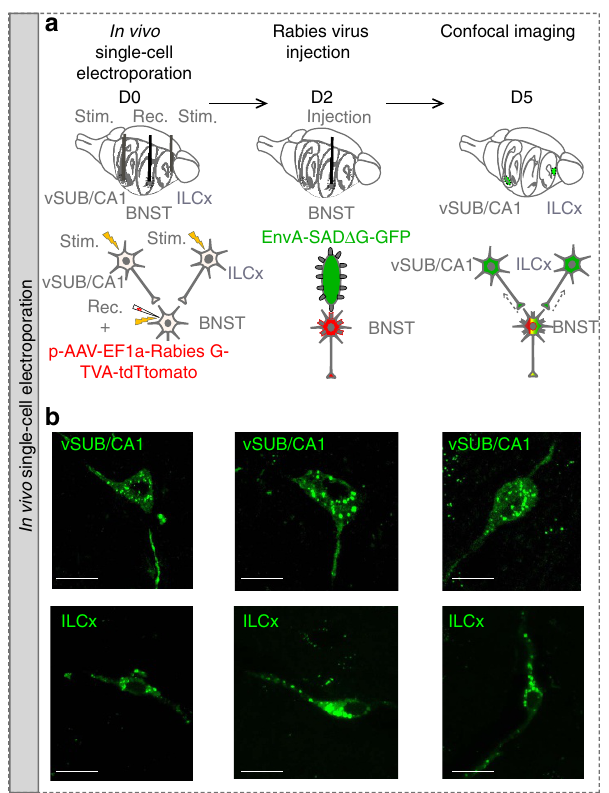
Figure 2 | Trans-synaptic tracing from single-electroporated amBNST neurons. ( a ) Experimental protocol of in vivo single-cell electroporation of amBNST neuron coupled with a recombinant monosynaptic retrograde- pseudotyped rabies virus strategy. A single-amBNSTneuron, responding to both ILCx and vSUB/CA1 stimulations, was electroporated in vivo with a plasmid coding for the rabies glycoprotein, the TVA receptor and a fluorescent marker (pAAV-EF1a-RabiesG-TVA-tdTomato). Two days later, a pseudotyped rabies (EnvA-SAD J G-GFP) was injected into the amBNST and will infect only the electroporated amBNST neuron. ( b ) Confocal images of vSUB/CA1 (top) and ILCx (bottom) GFP-positive neurons (scale bar, 10 m